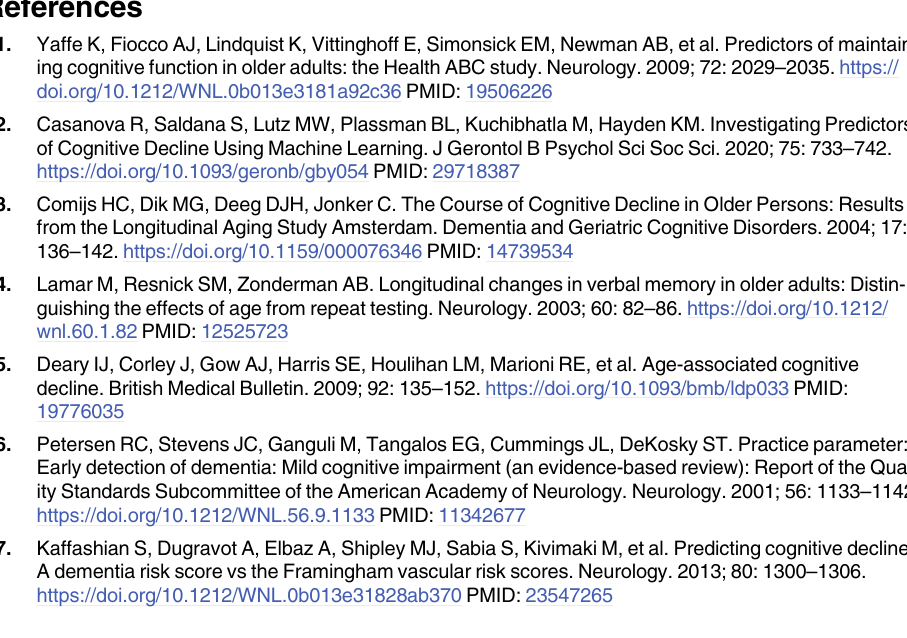
S1 Table. Supporting information about the selected factors from each of the seven domains (including sociodemographic, social engagement, health, psychology, physical functioning, health-related behaviors, and baseline cognitive tests). S2 Table. The hyper-parameter setting of different ML